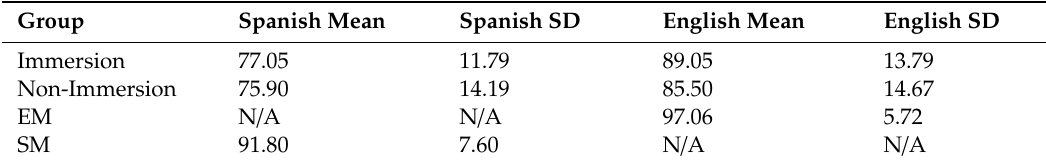
Table 2. Bilingual English Spanish Assessment (BESA) proficiency scores out of 100 by